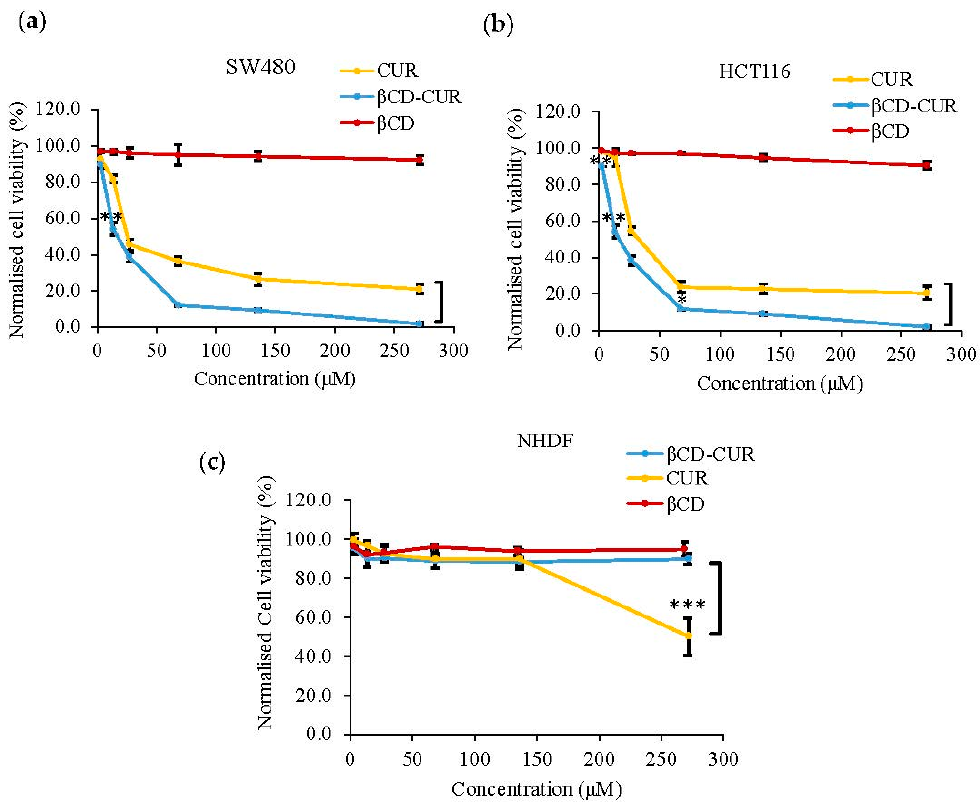
Figure 4. In vitro combined cytotoxic effects of β CD, CUR, and β CD-CUR. Normalized cell viability (%) after 24 h treatment against ( a ) SW480, ( b ) HCT116, and ( c ) NHDF cells. Data are shown as mean ± S.D. of three independent replicates, where statistically significant differences between CUR values versus β CD-CUR values are denoted as p < 0.05 (*), p < 0.01 (**), and p < 0.001 (***).